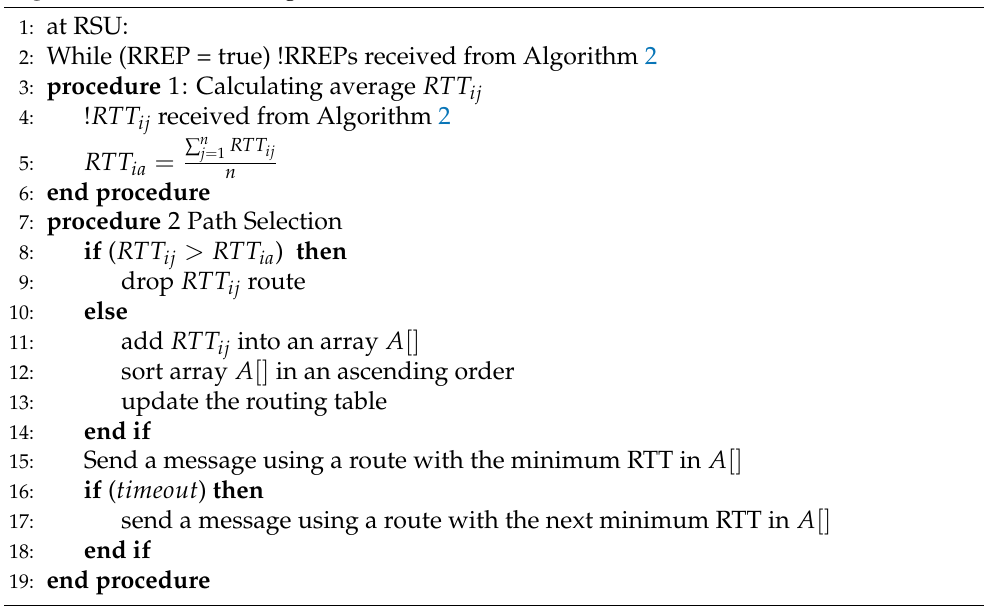
Algorithm 3 TMR Routing